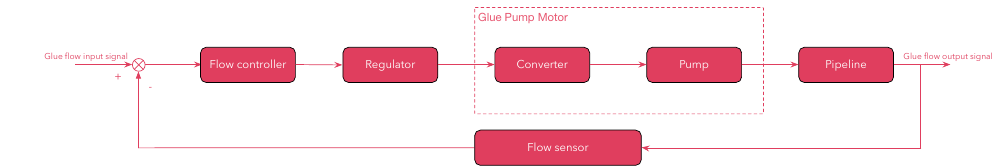
Figure 5. Schematic diagram of the glue-dosing